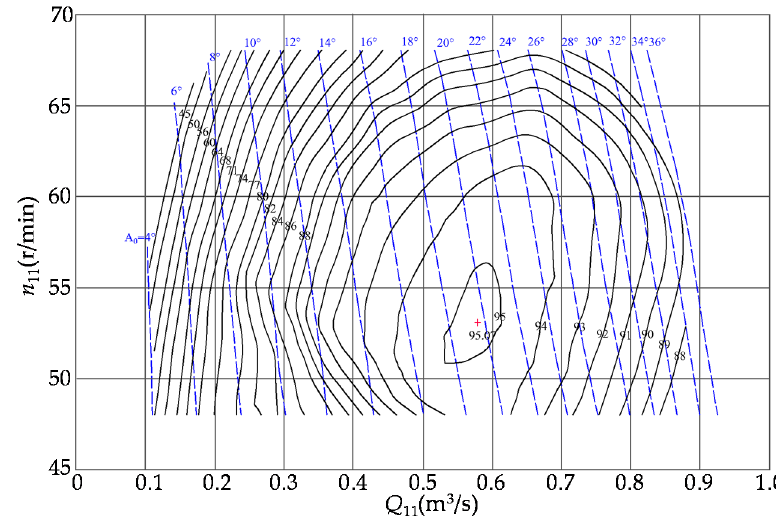
. From Figure 2, the optimal operating conditions